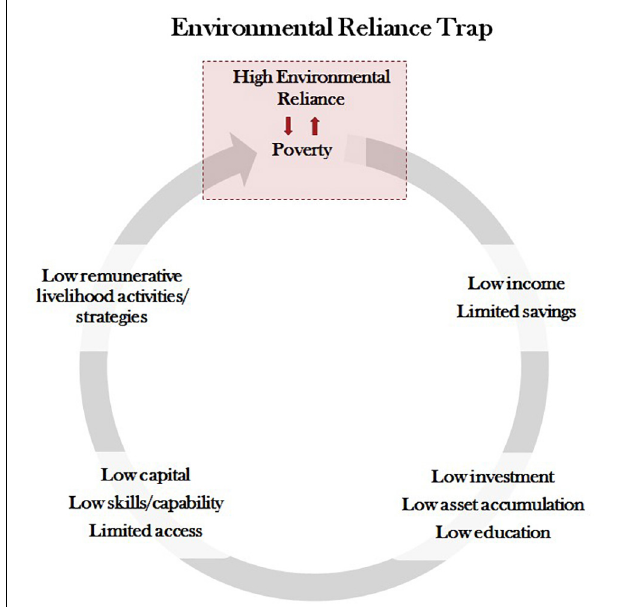
FIGURE 1 | The household-level self-reinforcing vicious cycle of an environmental reliance